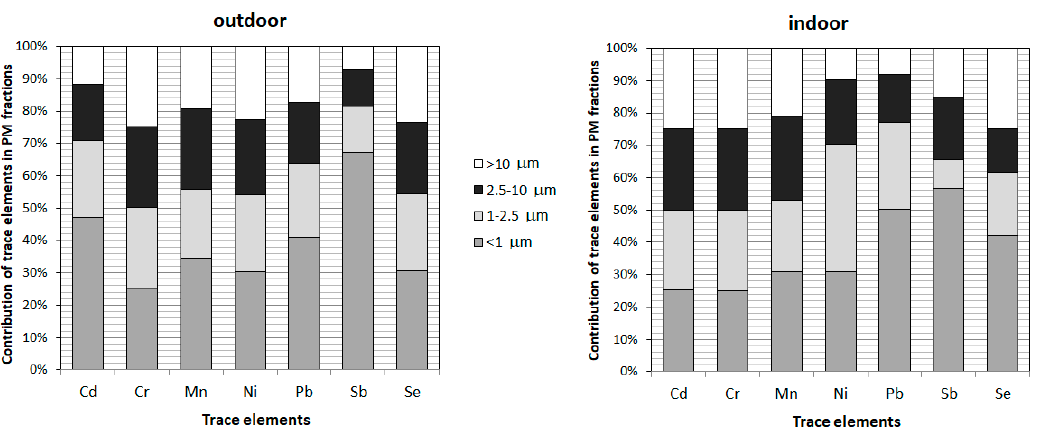
ff erent PM fractions ( < 1; 1 − 2.5; 2.5 − 10 and < 10 µ Figure 2. Contribution of trace elements in different PM fractions (<1; 1  2.5; 2.5  10 and <10  m). Figure 2. Contribution of trace elements in di